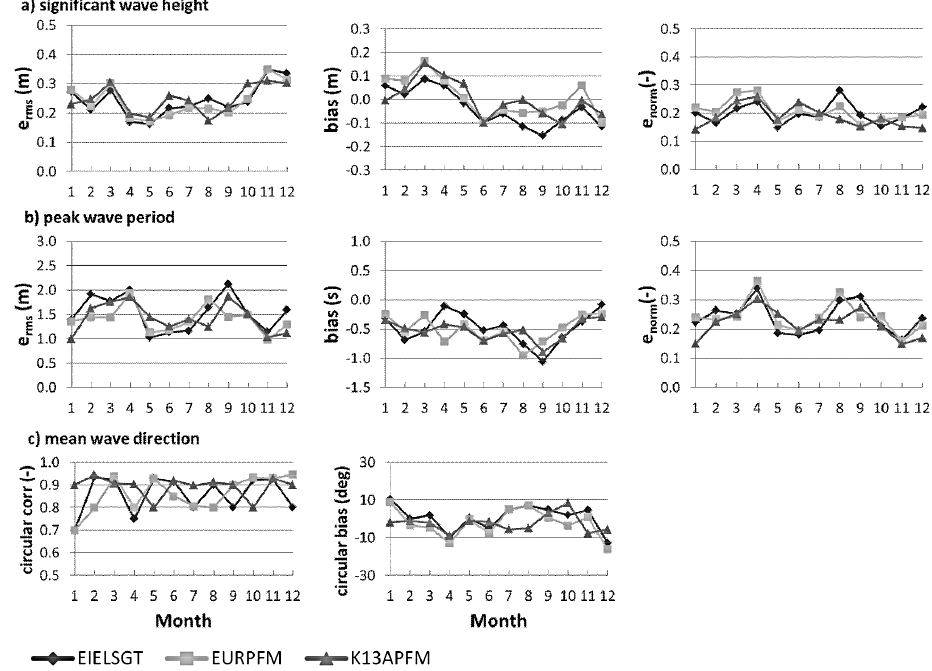
Figure 8. Monthly errors of wave parameters: (a) – wave height; (b) – peak period; (c) – mean wave direction.